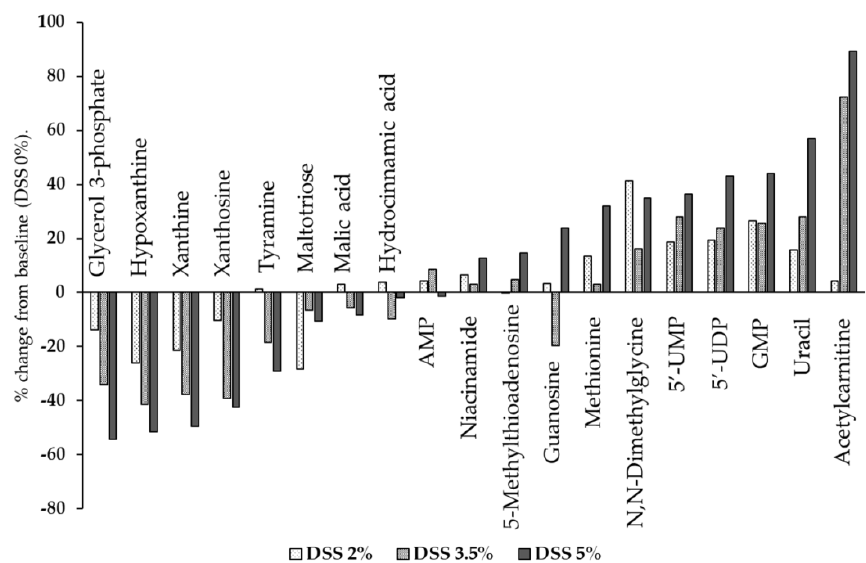
Figure 7. The percent change in liver metabolite levels in the DSS-treated mouse liver relative to the levels in normal liver. % Change = ([DSS-treated liver]–[control liver]) / [control liver] × 100). The concentrations of metabolites were calculated based on the integration of peak areas using SCIEX peak view. AMP, adenosine monophosphate; 5′-UMP, uridine 5′-monophosphate; 5′-UDP, uridine 5′-diphosphate; GMP, guanosine monophosphate. Table 3. The relative concentrations of marker metabolites, acquired by MS spectroscopy of DSS 0%, DSS 2%, DSS 3.5%, and DSS 5% livers.